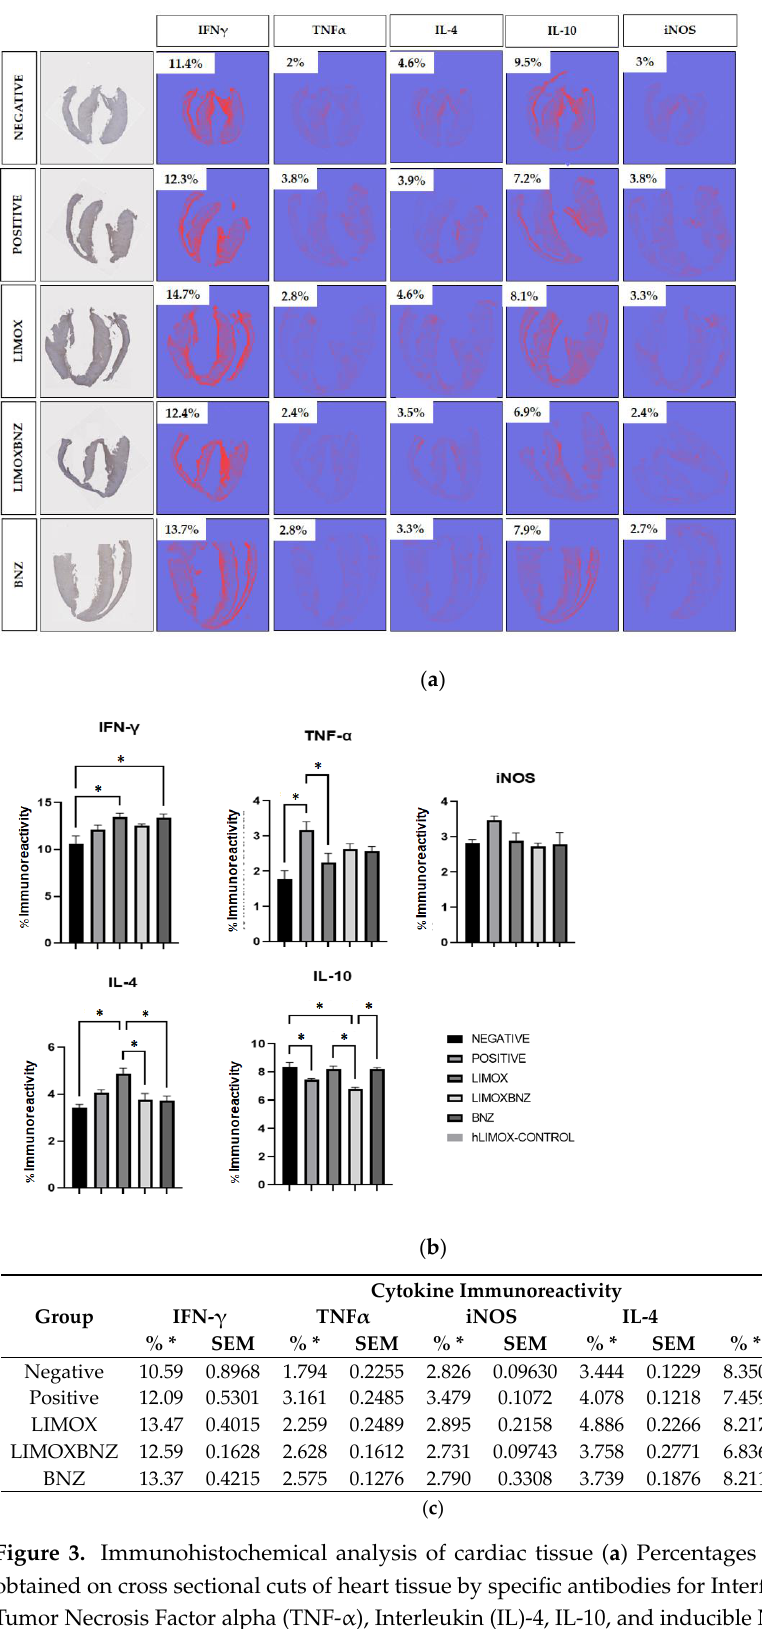
Figure 3. Immunohistochemical analysis of cardiac tissue ( a ) Percentages of immunoreactivity obtained on cross sectional cuts of heart tissue by specific antibodies for Interferon gamma (IFN- γ ), Tumor Necrosis Factor alpha (TNF- α ), Interleukin (IL)-4, IL-10, and inducible Nitric Oxide